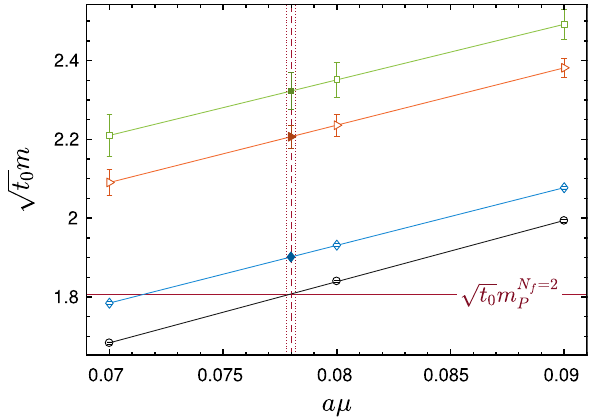
Fig. 3 Interpolation of the measured pseudoscalar masses (circles) on the N f = 0 ensemble qW (see Table 1). The horizontal line depicts the tuning point Eq. (3.32). The vertical lines are the resulting interpolated twisted mass parameter a μ (cid:15) and its statistical error. The measured vec- tor, scalar and tensor mesons masses (diamonds, triangles and squares respectively) can then be interpolated to the tuning point, resulting in the corresponding solid markers. In their error bars all the correlations among the data have been taken into